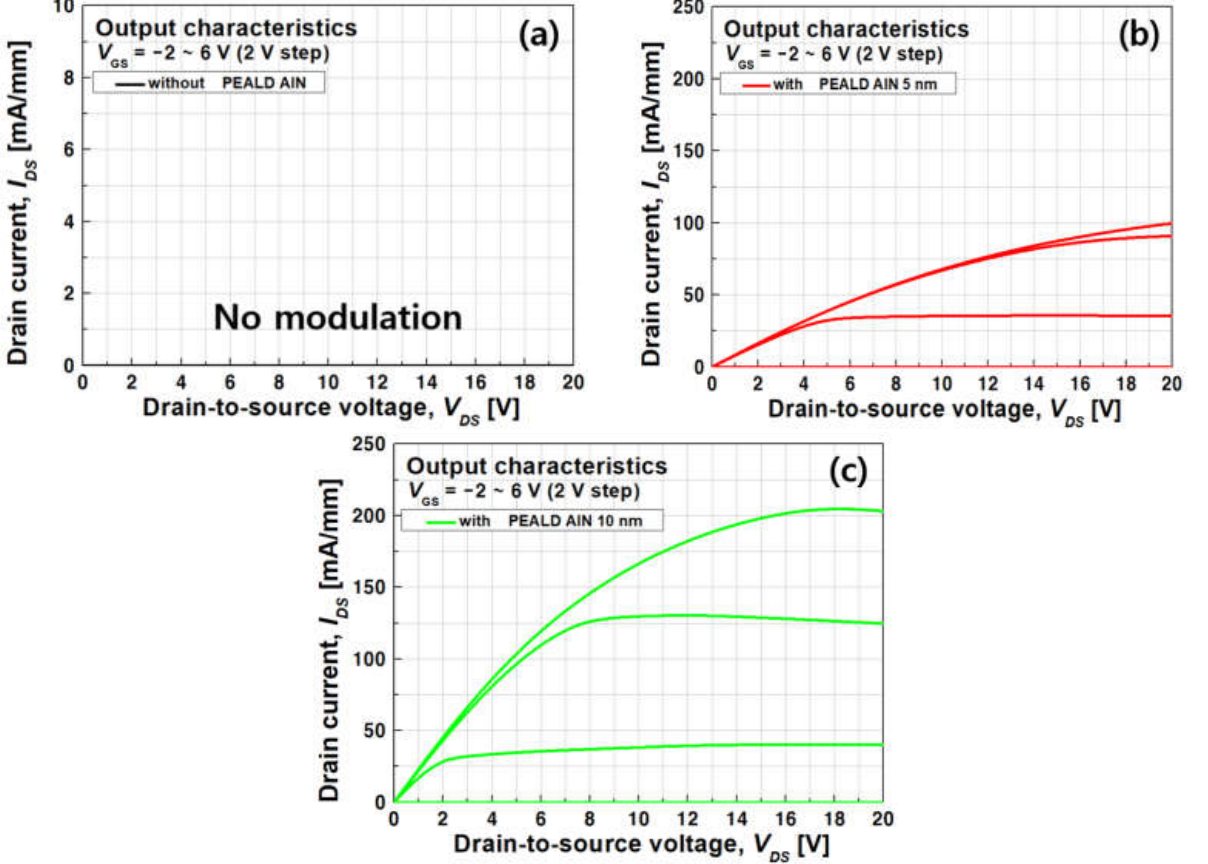
Figure 11. Output current–voltage characteristics of fabricated thin-AlGaN/GaN MIS-HFETs; ( a ) without PEALD AlN film, ( b ) with a 5 nm thick PEALD AlN film, and ( c ) with a 10 nm thick PEALD AlN film.